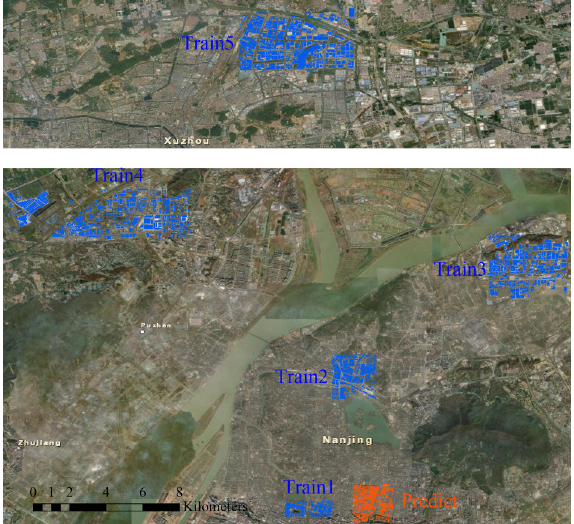
Figure 5 Four areas near Nanjing and one area near Xuzhou were selected for training, and one area near Nanjing was selected for vector data update location discovery.